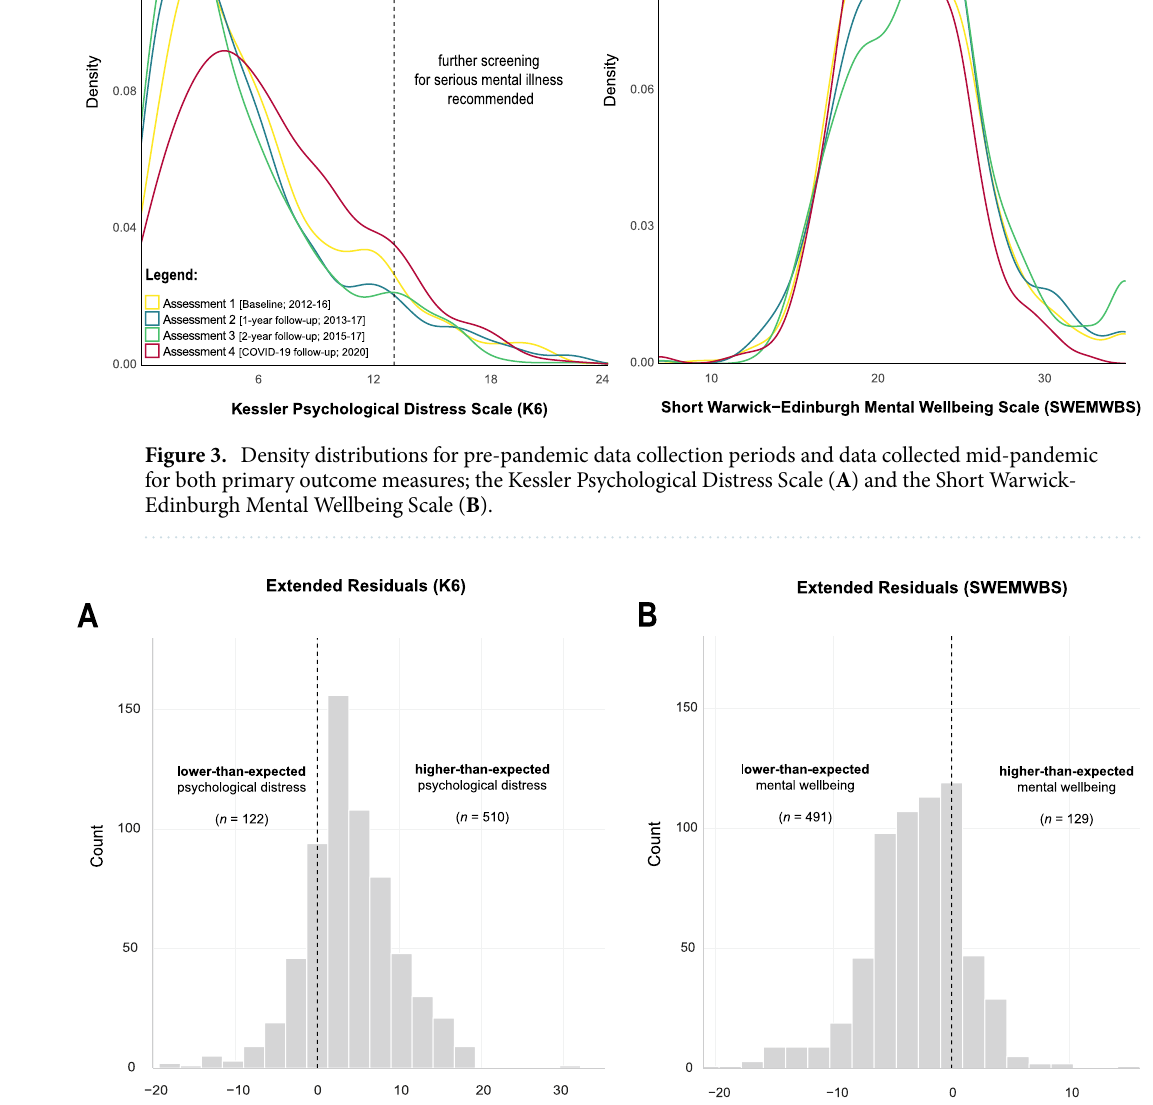
Figure 4. Extended residual scores for both primary outcome measures; the Kessler Psychological Distress Scale ( A ; n = 632) and the Short Warwick-Edinburgh Mental Wellbeing Scale ( B ; n =